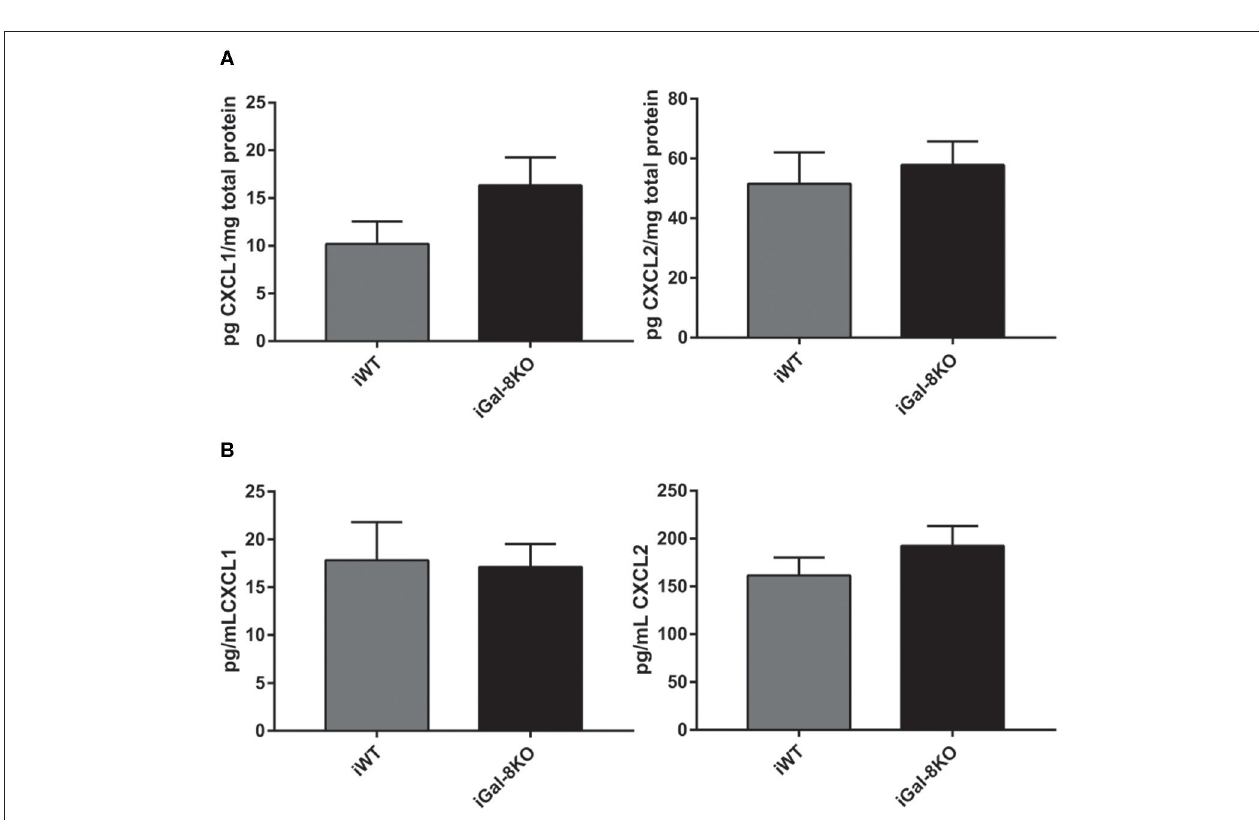
FIGURE 8 | CXCL1 and CXCL2 levels in infected wild-type (WT) and Gal-8KO mice. Neutrophil chemoattractants were measured in cardiac lysates (A) and serum samples (B) by ELISA and normalized to total cardiac protein measured by the Bradford method (5 animals/group).